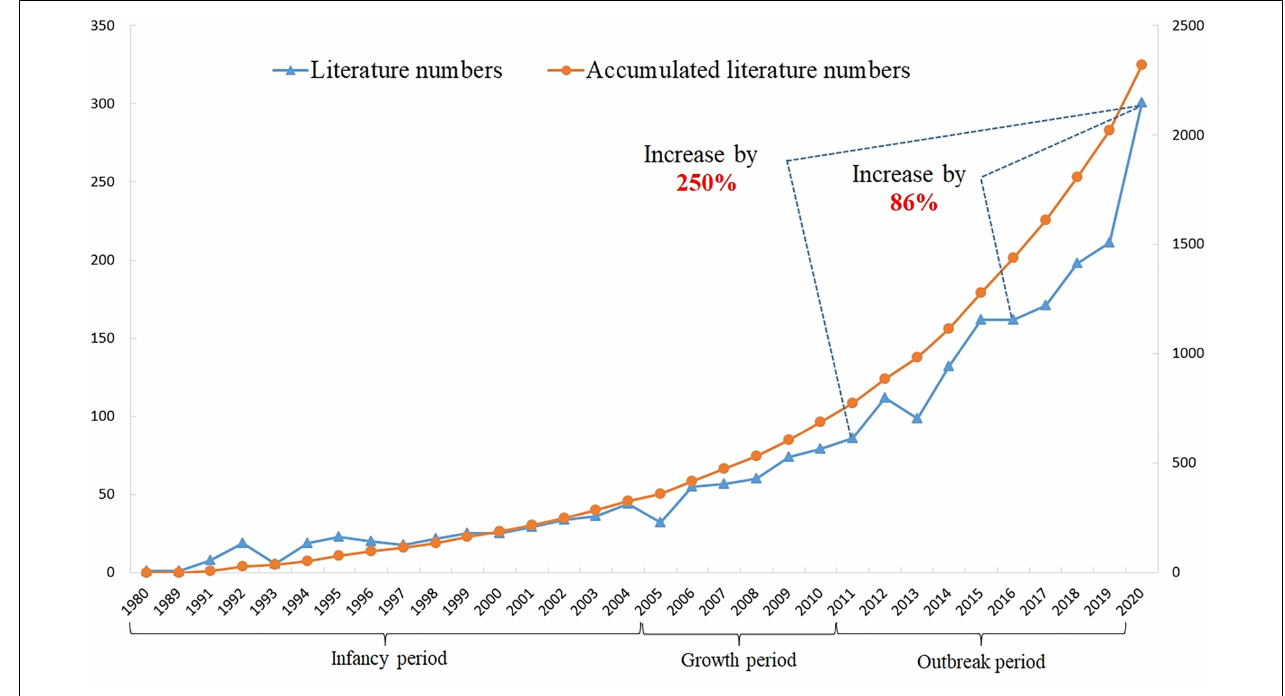
FIGURE 2 | Annual numbers and growth rates of citizen’s environmental behavior related